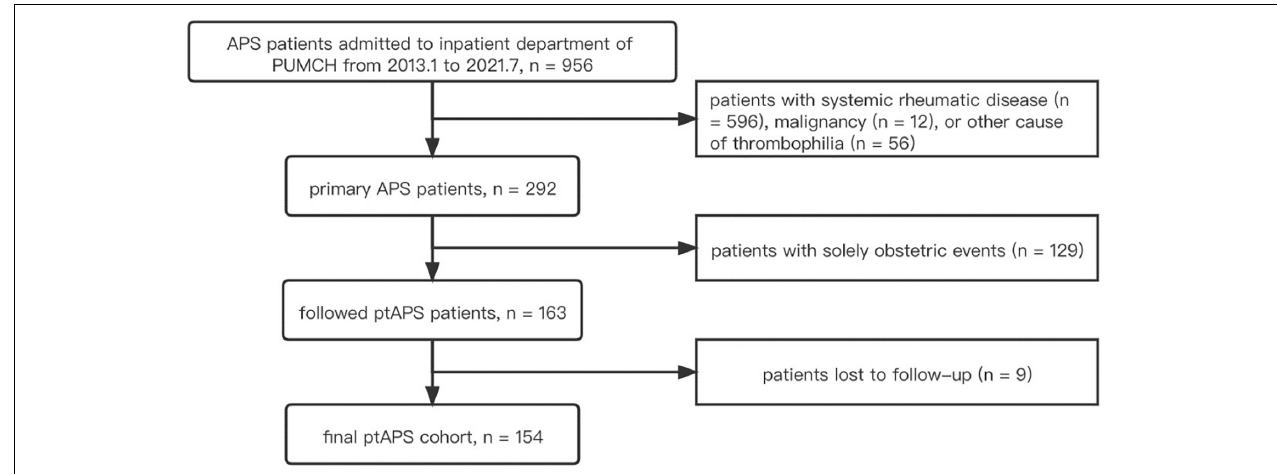
FIGURE 1 | A flowchart of patient screening. APS, antiphospholipid syndrome; PUMCH, Peking Union Medical College Hospital; ptAPS, primary thrombotic antiphospholipid